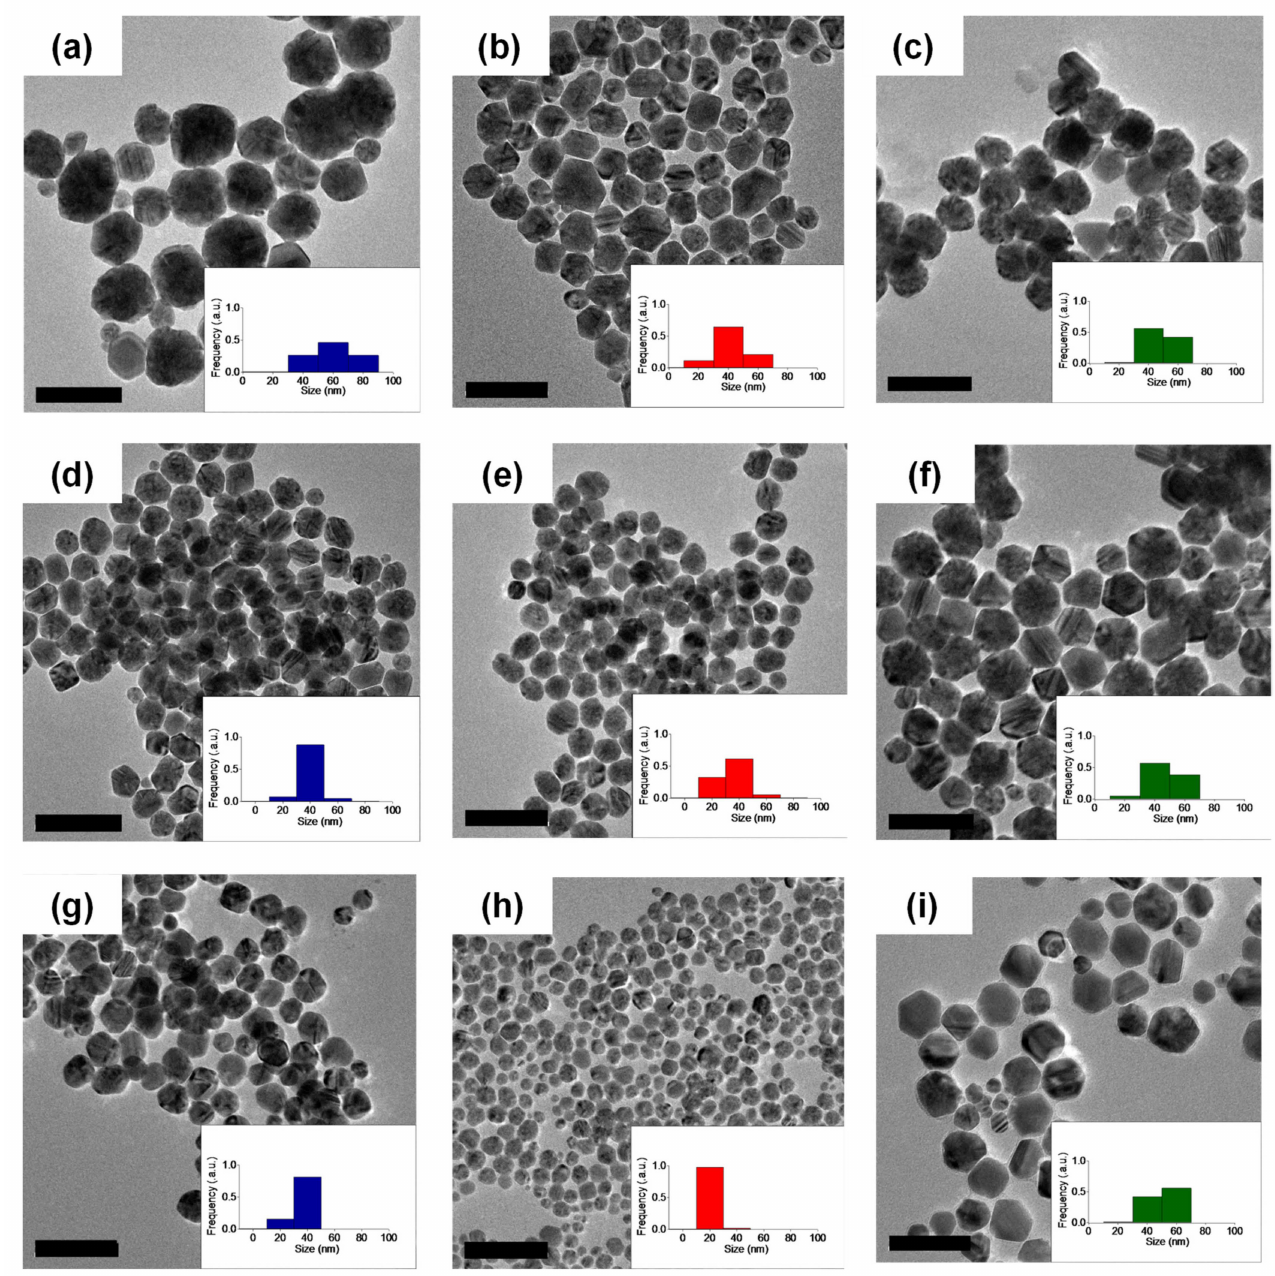
Figure 1. TEM micrographs of AgNPs prepared in the presence of ( a ) HO–PEG 5k –OH ( ω = 2.2), ( b ) c -PEG 5k ( ω = 2.2), ( c ) MeO–PEG 5k –OMe ( ω = 2.2), ( d ) HO–PEG 5k –OH ( ω = 11), ( e ) c -PEG 5k ( ω = 11), ( f ) MeO–PEG 5k –OMe ( ω = 11), ( g ) HO–PEG 5k –OH ( ω = 44), ( h ) c -PEG 5k ( ω = 44), and ( i ) MeO–PEG 5k –OMe ( ω = 44) (Scale bar: 100